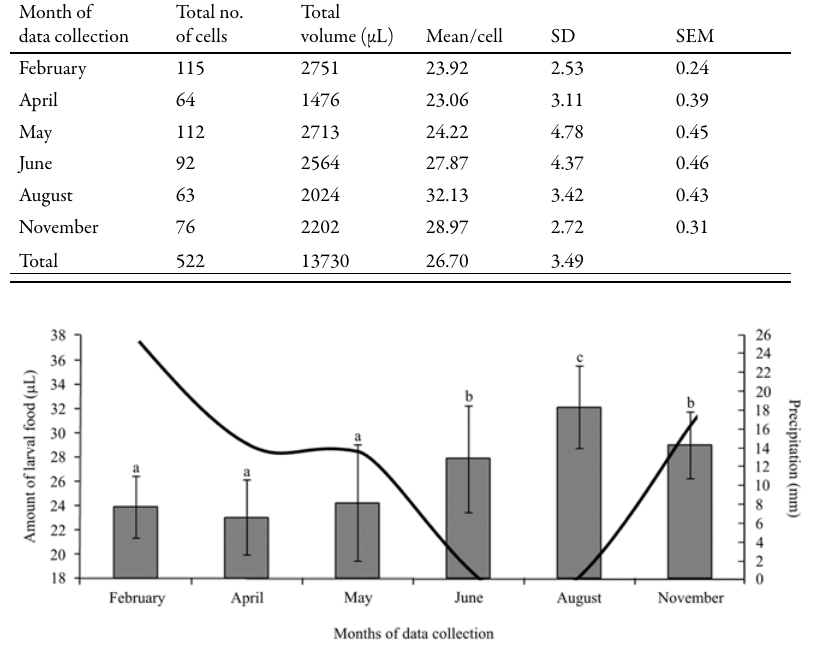
Fig. 3 . Variation of the amount of larval food (µL) in brood cells of Frieseomelitta varia (n=522 cells), during the collection months (2007-2008) and the relation with precipitation (mm). Tukey’s Test (p< 0,050). Different letters indicate statistically significant differences among